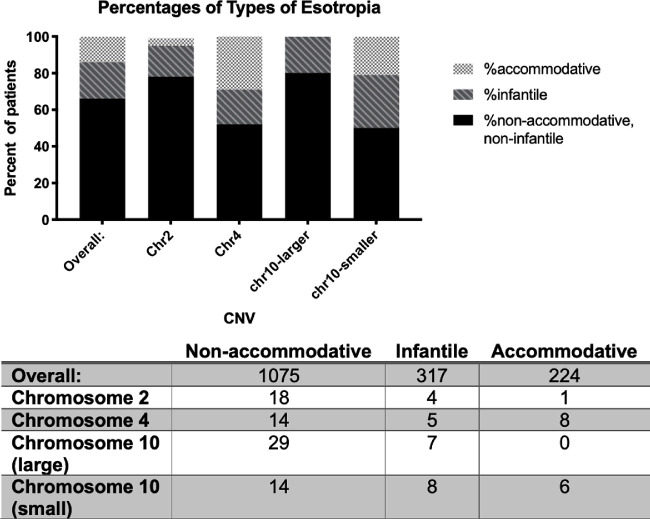
Distribution of subtypes of esotropia. The overall esotropia cohort consists of 14% accommodative (light grey checkerboard), 20% infantile (dark gray stripes), and 66% nonaccommodative, noninfantile (black). Accommodative esotropia is underrepresented in the chromosome 2 and larger chromosome 10 duplications, and overrepresented in the chromosome 4 duplication. P = 0.069, chi square. Numbers of participants in each group are provided in the table.